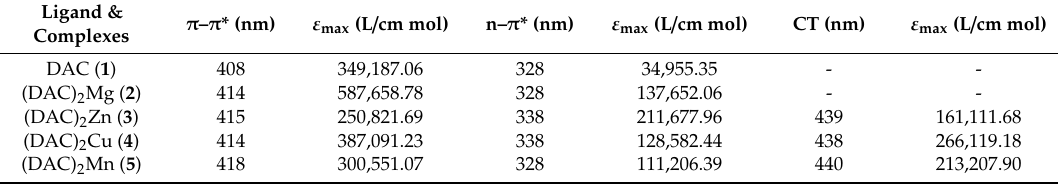
Table 1. Transition bands in ultraviolet-visible (UV-Vis) spectra for ligand and complexes.